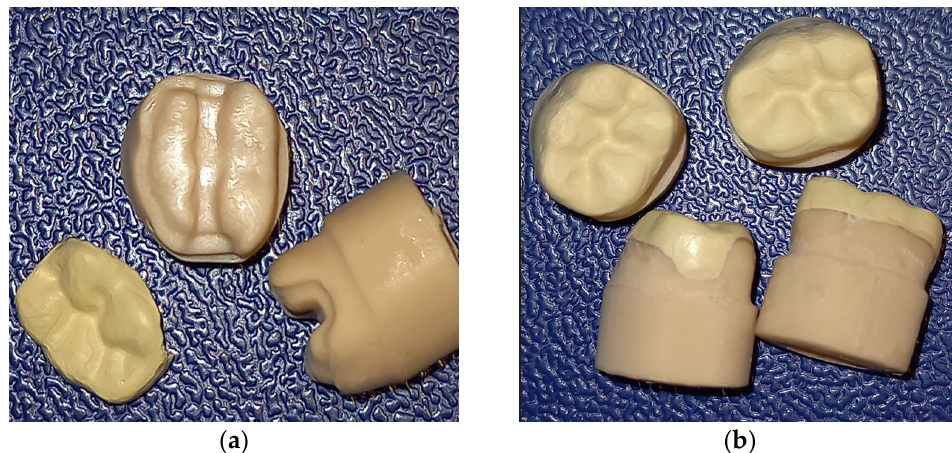
Figure 1. Three-dimensional printed abutments ( a ) and milled polymer onlays ( b ) with cemented onlays.